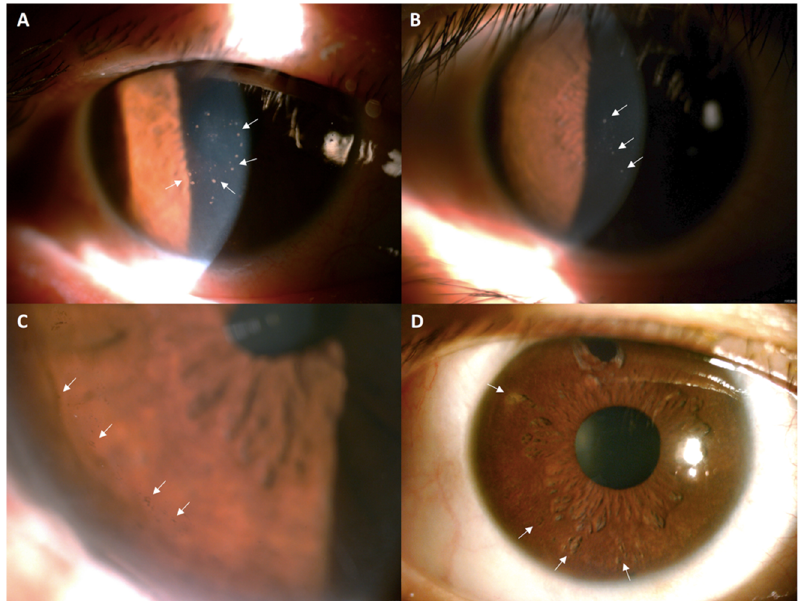
Figure 1. Clinical manifestations of cytomegalovirus corneal endotheliitis by slit-lamp biomicroscopy. ( A ) Typical coin-shaped keratic precipitates (KPs) (white arrows) in the central cornea of case 1. ( B ) Some mutton-fat KPs (white arrows) in case 7. ( C ) Pigmented KPs (white arrows) in the peripheral cornea of case 10. ( D ) Moth-eaten iris atrophy (white arrows) in case 3.